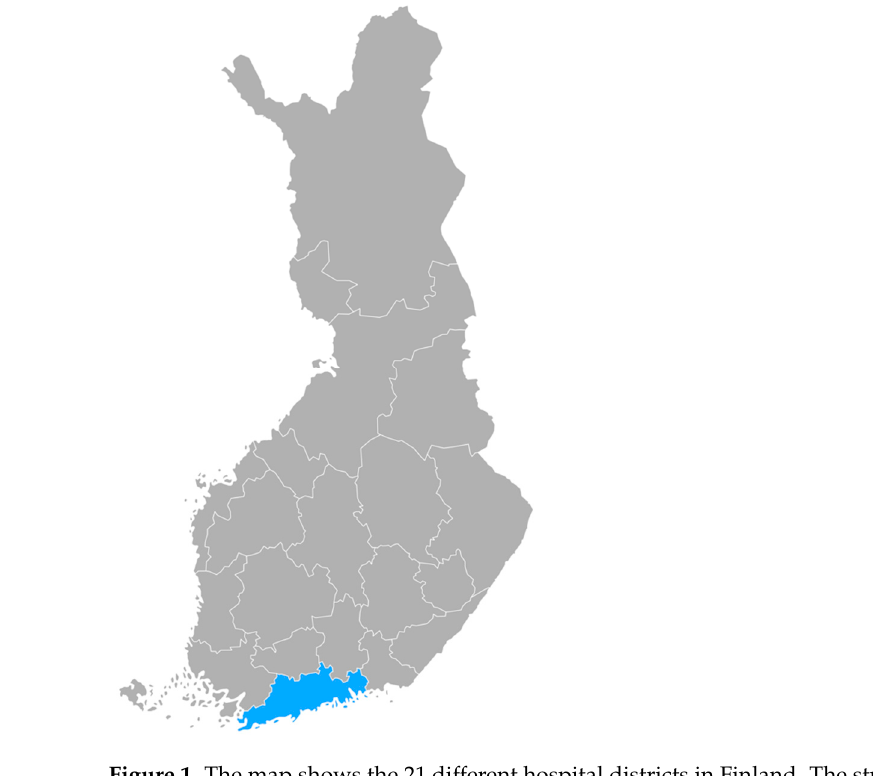
Figure 1. The map shows the 21 different hospital districts in Finland. The study area, the Hospital District of Helsinki and Uusimaa (HUS), is shown in blue.